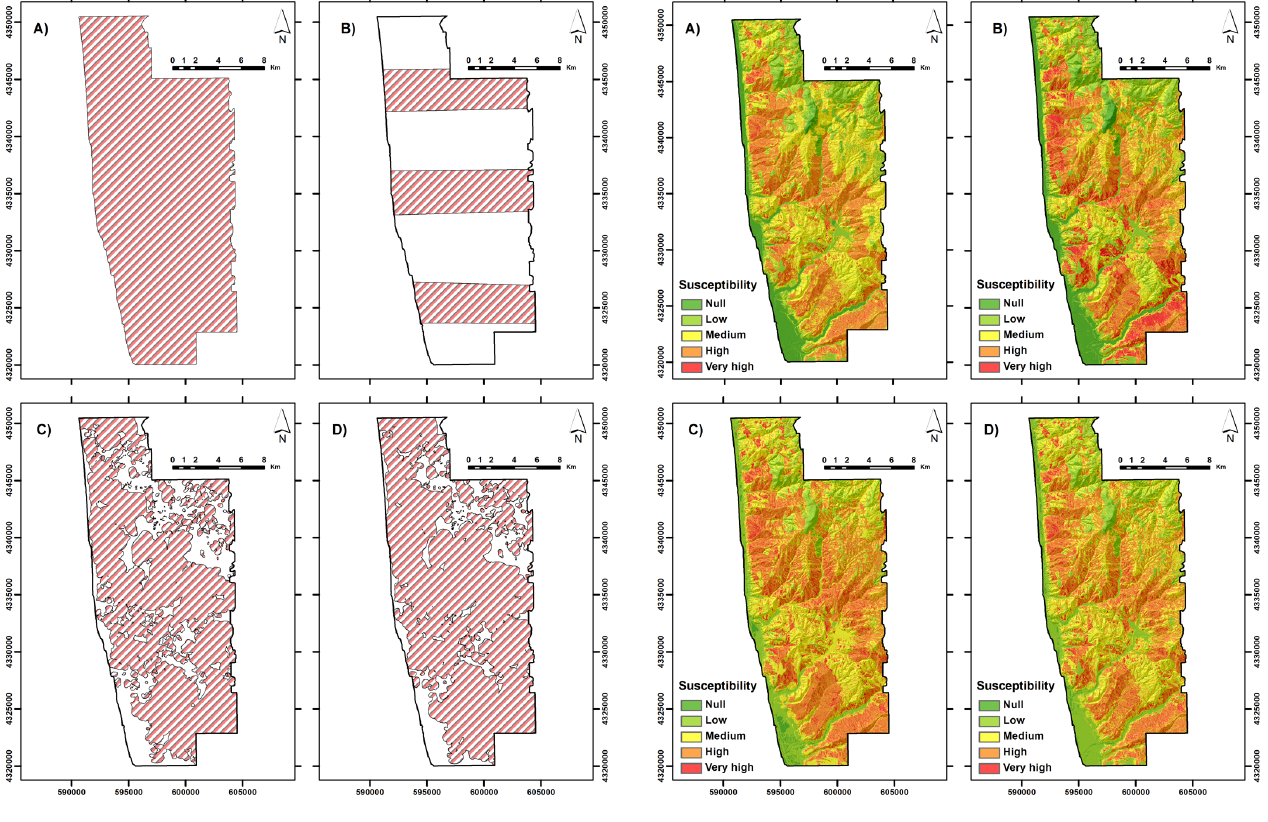
Fig. 3. Tested sampling area: (A) All area; (B) Transects; (C) Buffer 1 / 1; (D) Buffer 1 / 2.